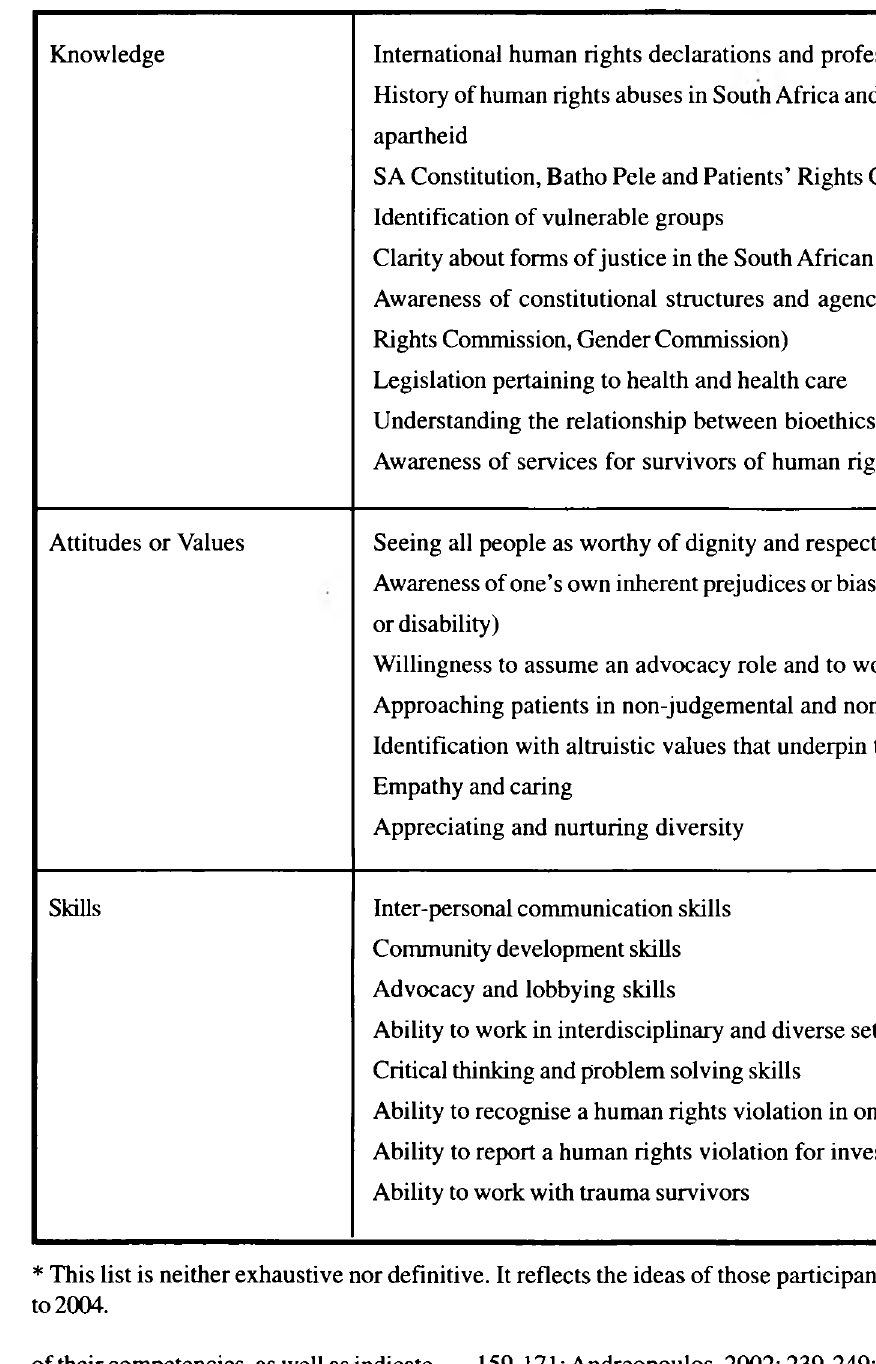
Table 4. Core Competencies for Human Rights Training in Health*